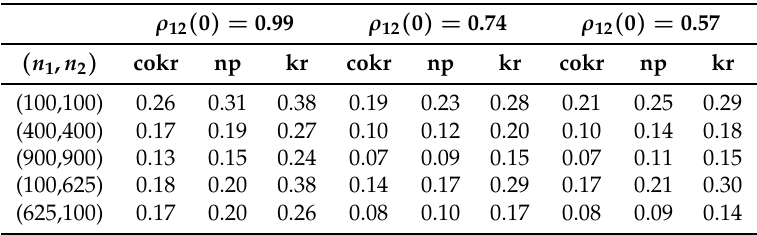
Table 1. AMSPE values obtained for several sample sizes n 1 and n 2 and correlations ρ 12 , for data drawn from random fields Z 1 and Z 2 with constant trends, derived from Gaussian processes V 1 and V 2 with nugget and spherical semivariograms, respectively. For implementation of the kriging and cokriging approaches, the dependence structures of V 1 and V 2 were estimated through the theoretical models.